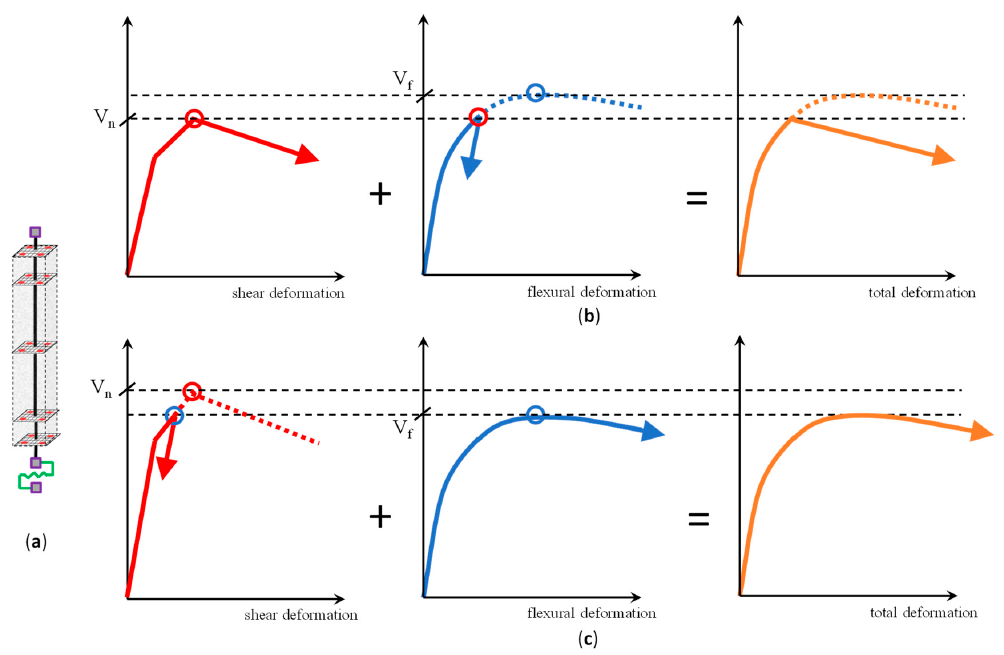
Figure 10. Combination of the single response components in shear-flexure interaction model: ( a ) Two-component model; ( b ) Response controlled by shear failure and ( c ) Response controlled by flexural failure.